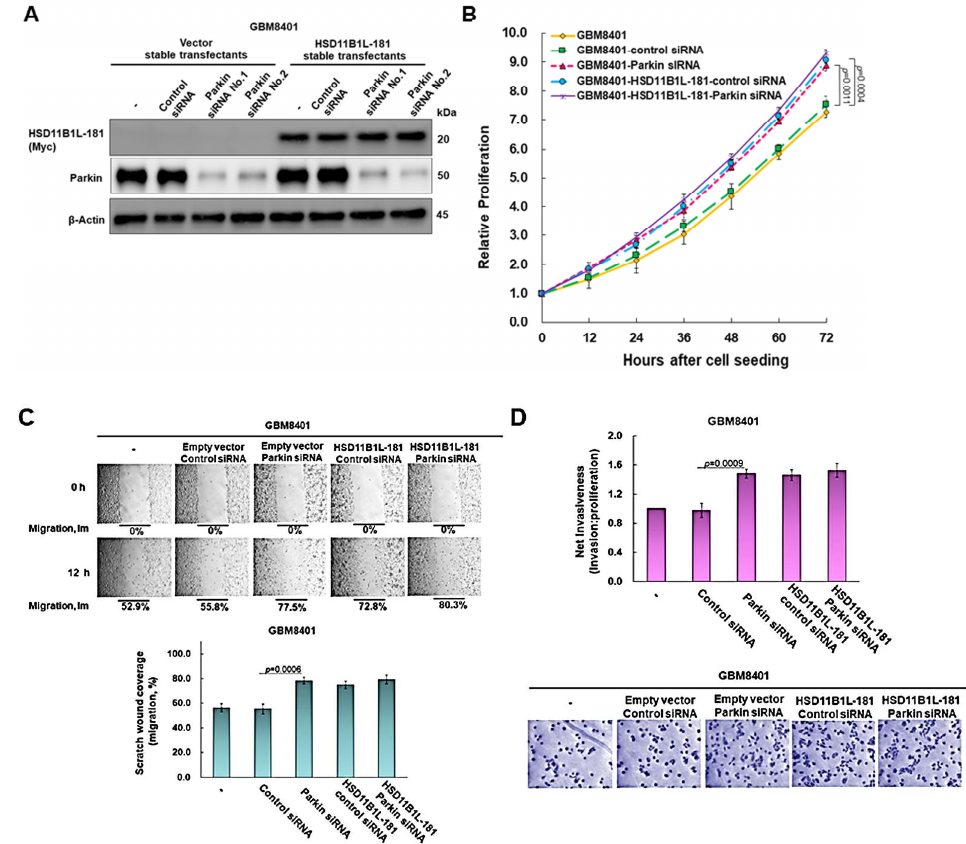
Figure 6. Overexpression of HSD11B1L-181 enhanced the proliferation, migration and invasion properties of GBM cells in part by inhibiting the activity of parkin. GBM8401 cells in the control vector group or HSD11B1L-181 overexpression group were delivered parkin-specific or control non- specific siRNA. After 24 h of culture, the cell proliferation, migration and invasion abilities were analyzed. ( A ) The expression of HSD11B1L-181-myc and parkin was detected using Western blot. β-actin is the internal loading control. ( B ) Cell proliferation capacity was measured via the CellTiter Blue Cell Viability assay. ( C ) Scratch test to determine cell migration ability (top). The bar graph presents quantitative data (bottom). ( D ) Cell invasion ability was determined by a transwell invasion assay. Cells invading the basement membrane were fluorescently stained and quantified 24 h after the experiment (top) and finally confirmed with crystal violet staining